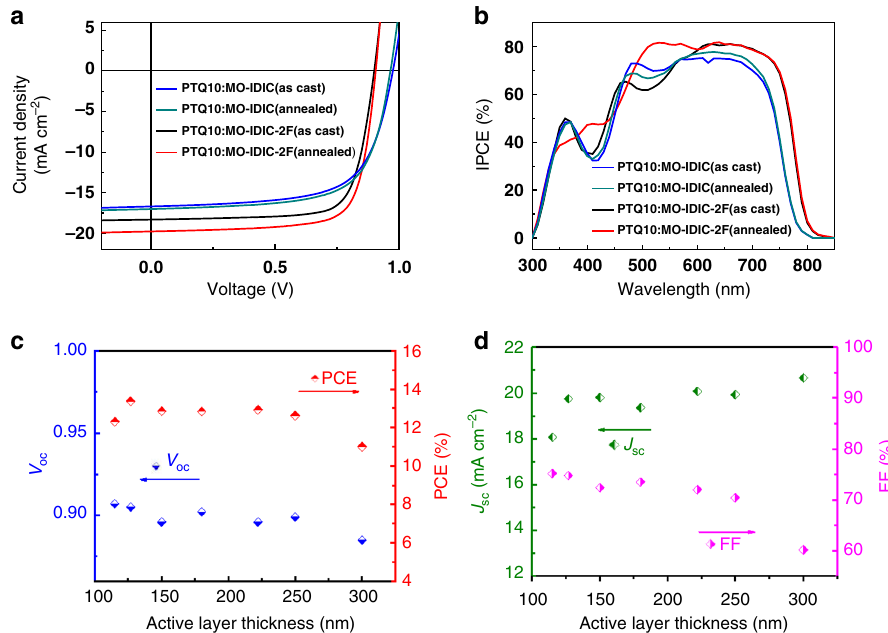
Fig. 3 Photovoltaic performance of the PSCs. a J – V curves of the optimized PSCs based on PTQ10: acceptors (1:1) without (as-cast) and with thermal annealing at 120 o C (for the MO-IDIC-based devices) or 110 o C (for the MO-IDIC-2F-based devices) for 5 min, under the illumination of AM 1.5 G, 100 mW cm − 2 ; b IPCE spectra of the corresponding PSCs. Plots of c V oc or PCE and d J sc or FF vs. the active layer thickness ranging from 115 to 300 nm for the